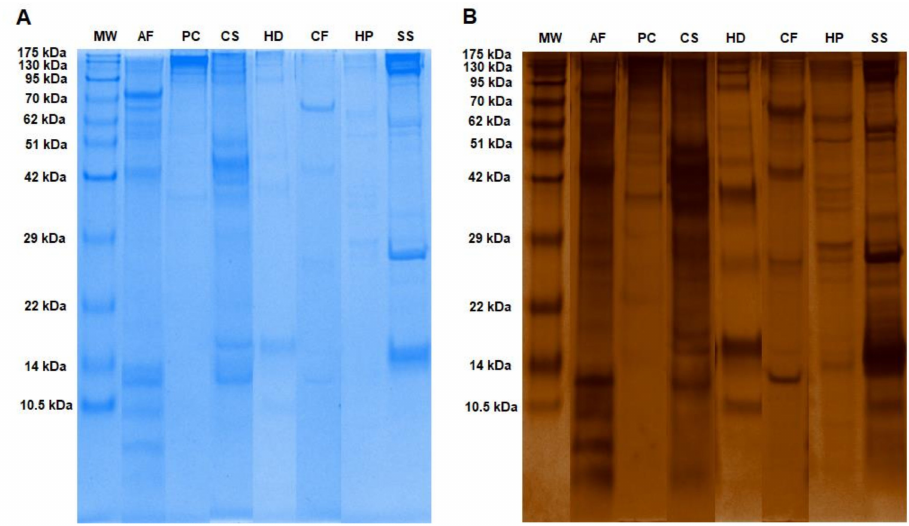
Figure 1. Mucus samples from seven gastropod species separated on 1D-SDS polyacrylamide gels. The gels were stained with Coomassie brilliant blue ( A ) and silver nitrate ( B ). By lane: 1, MW = protein molecular marker; 2, AF = Achatina fulica ; 3, PC = Pomacea canaliculata ; 4, CS = Cryptozona siamensis ; 5, SS = Semperula siamensis ; 6, HD = Hemiplecta distincta ; 7, CF = Cyclophorus fulguratus ; and 8, and HP = Helix pomatia